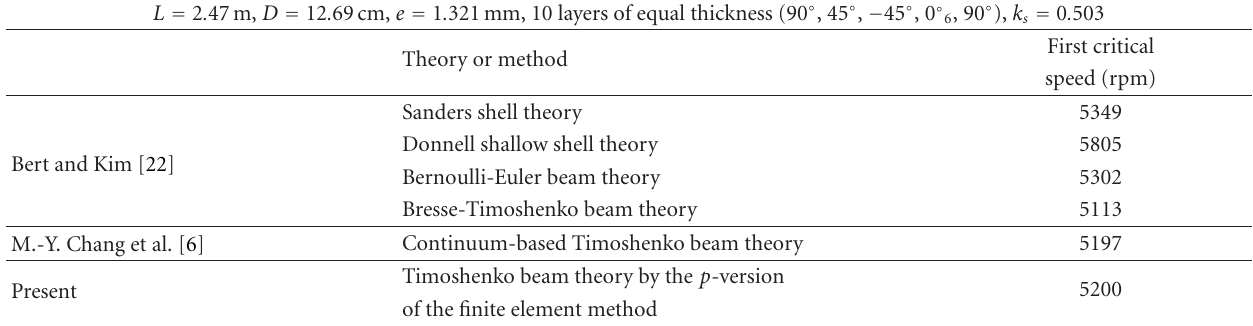
Table 3: The critical speed of the graphite-epoxy composite shaft.